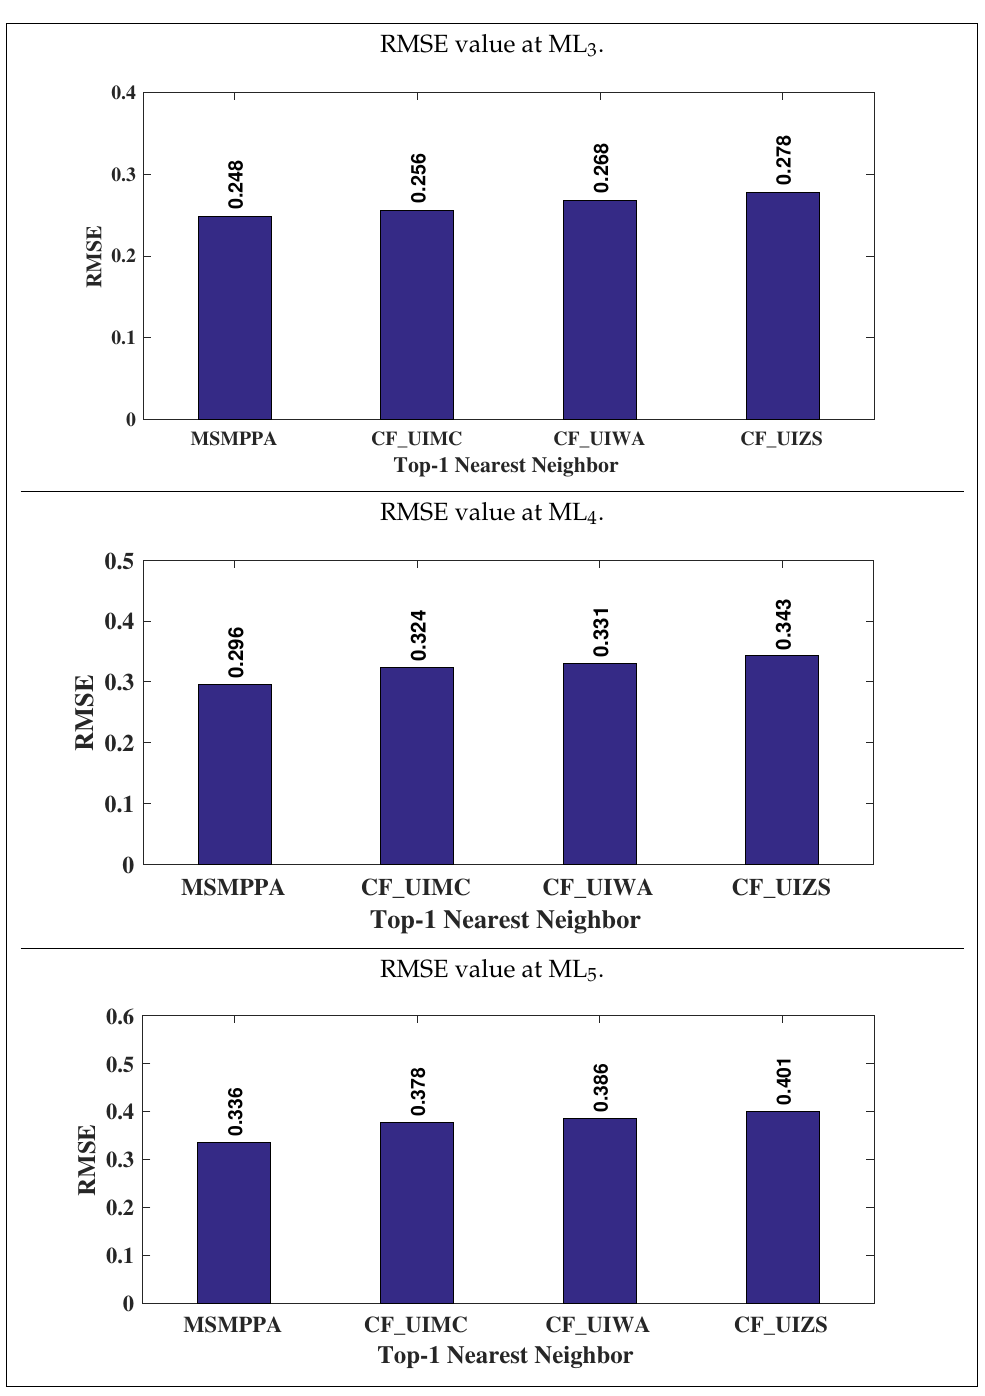
Figure 17. RMSE Value at